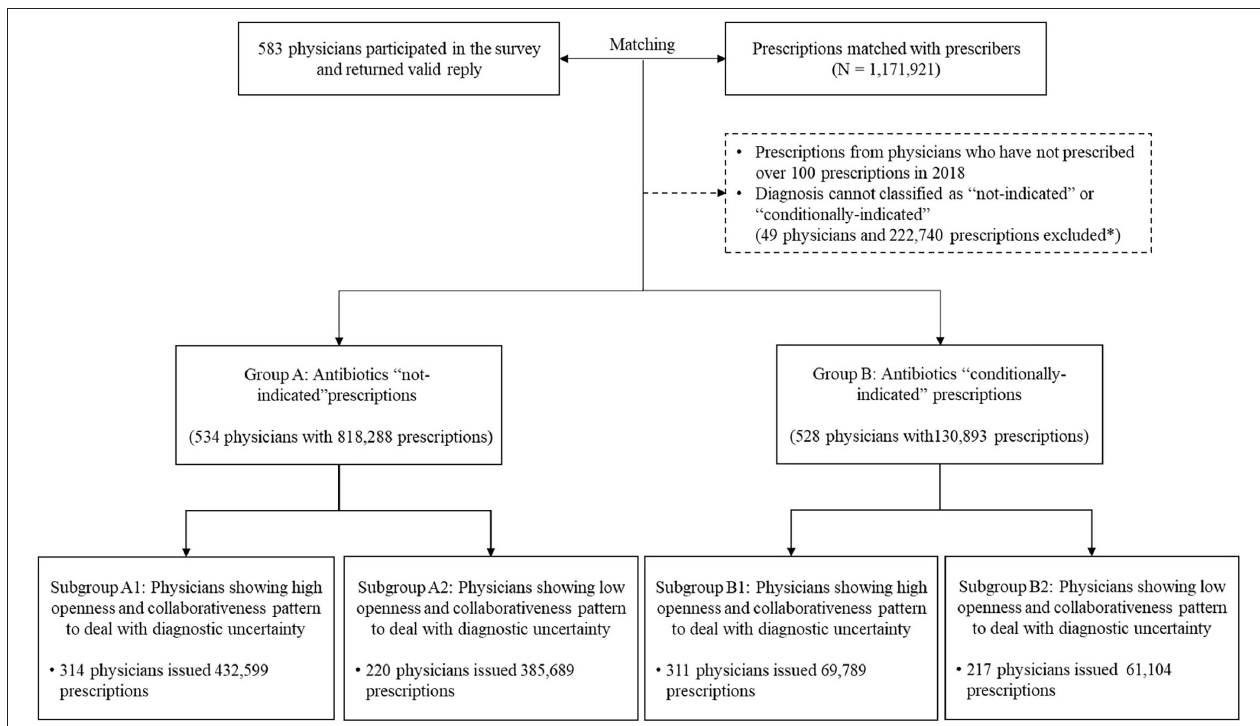
FIGURE 1 | Matching process and characteristics of prescriptions in different groups. Participating physicians and their prescriptions over 2018 were first matched. Based on recorded diagnoses, prescriptions were divided into two groups, namely, illness without an indication for antibiotics (Group A) and illness with an indication conditional for antibiotics (Group B). The former group represents diagnoses that are unlikely to be caused by bacteria for which antibiotics should not be prescribed and the latter one covers diagnoses that antibiotic prescriptions may be needed conditional to a cause of bacterial infections, for example, acute tonsillitis. In either group, two sub-groups were further identified based on physicians’ behavioral patterns to cope with diagnostic uncertainty. *Among all the excluded prescriptions, 70.93% prescriptions were excluded due to missing diagnosis, 18.70% were prescriptions with diagnosis requiring antibiotics and 10.37% were due to ineligible physicians ( < 100 prescriptions during 2018 or missing data of personal